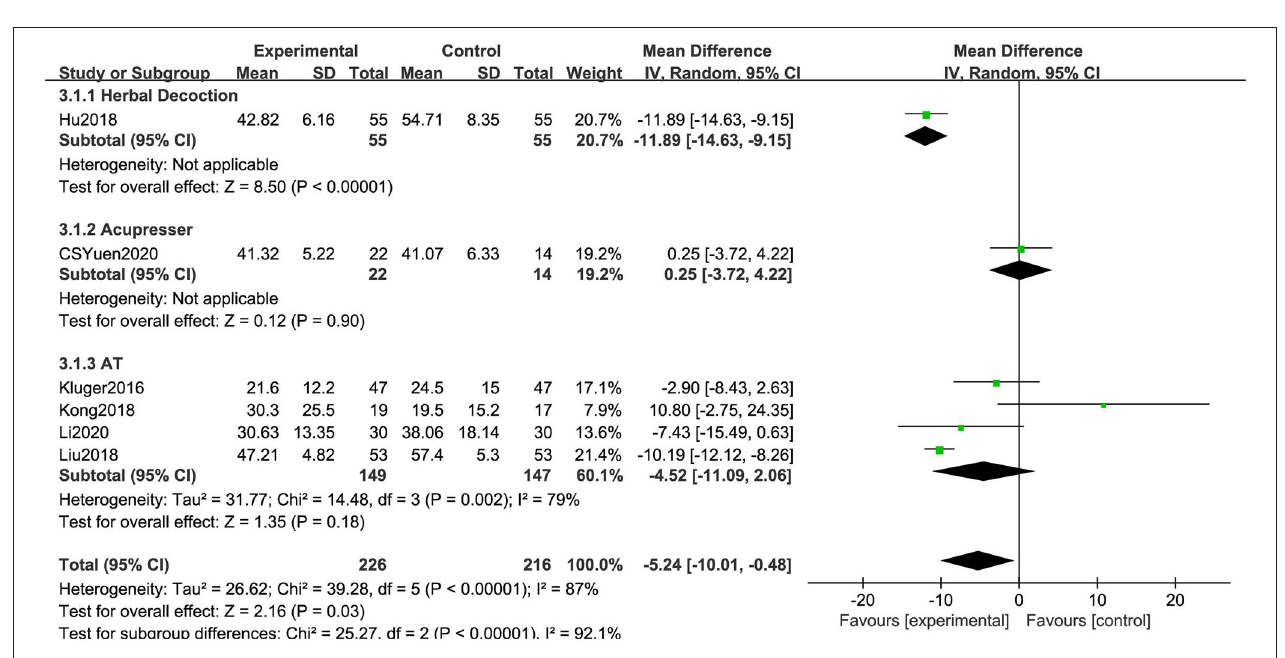
FIGURE 9 | Comparison of acupuncture related therapies in terms of PDQ-39.